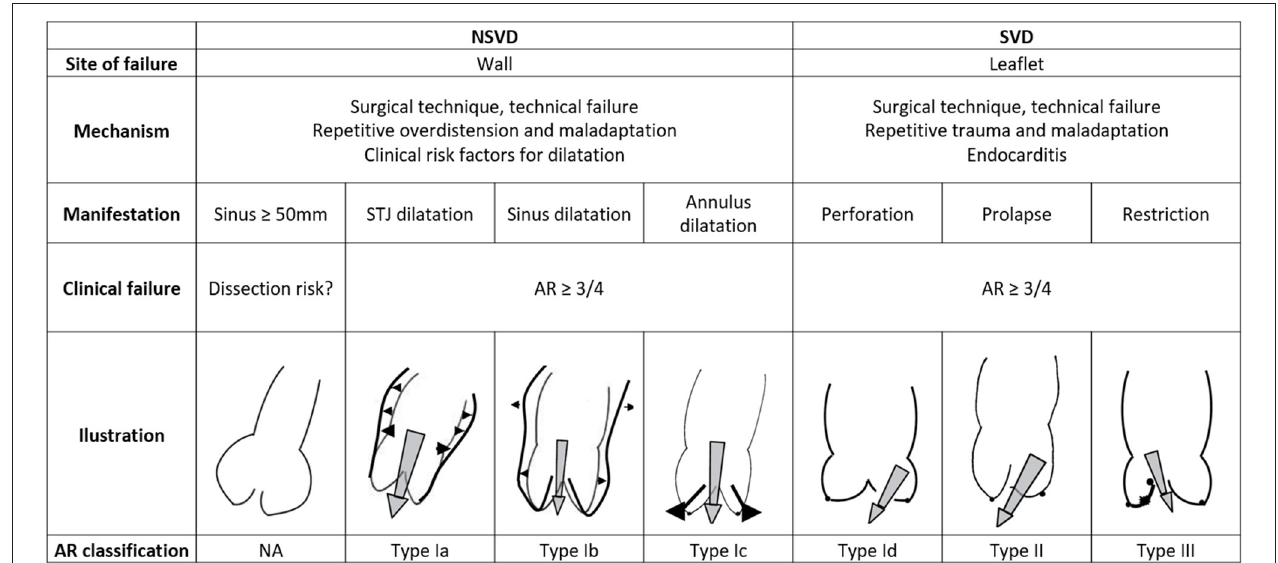
FIGURE 3 | Classification of the failure mechanisms of the Ross procedure and correlation with El Khoury’s functional classification of aortic regurgitation. AR, aortic regurgitation; SVD, structural valvular degeneration; NSVD, non-structural valvular degeneration. Illustrations adapted with permission from Boodhwani et al. ( 39).